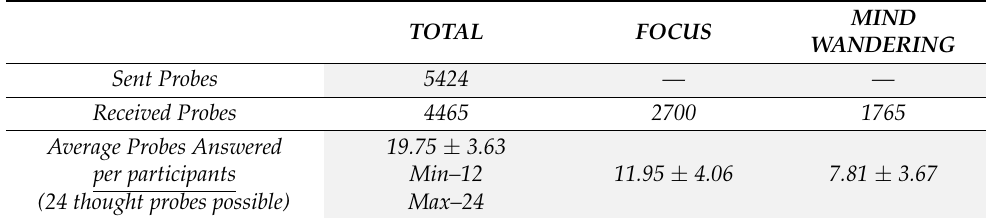
Table 1. Mind wandering’s probes: Descriptive Statistics on 226 participants.